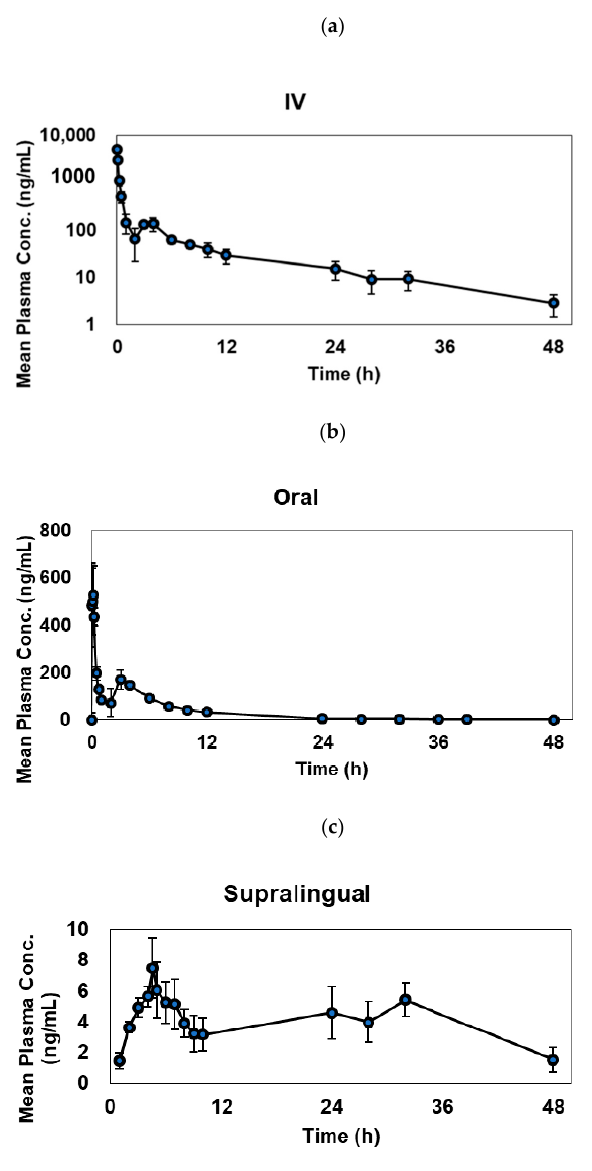
Figure 2. Average (mean ± standard deviation) pharmacokinetic profiles of mycophenolic acid after three different administrations: ( a ) IV ( n = 5); ( b ) oral ( n = 3); ( c ) supralingual ( n = 3).